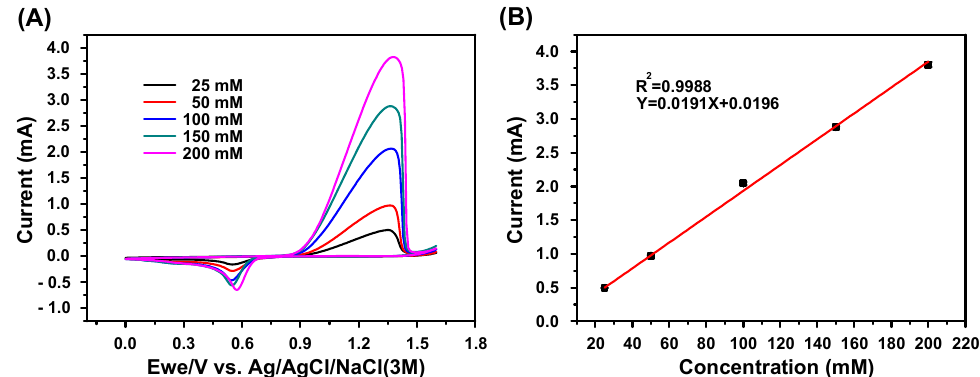
Figure 5. Cl − detection using cyclic voltammetry (CV): ( A ) cyclic voltammograms (100 mV/s) for various Cl − concentrations (25–200 mM); ( B ) linear calibration curve representing the relation between the stable oxidization peak current and concentration; scanning range: 0–1.6 V, N = 3.